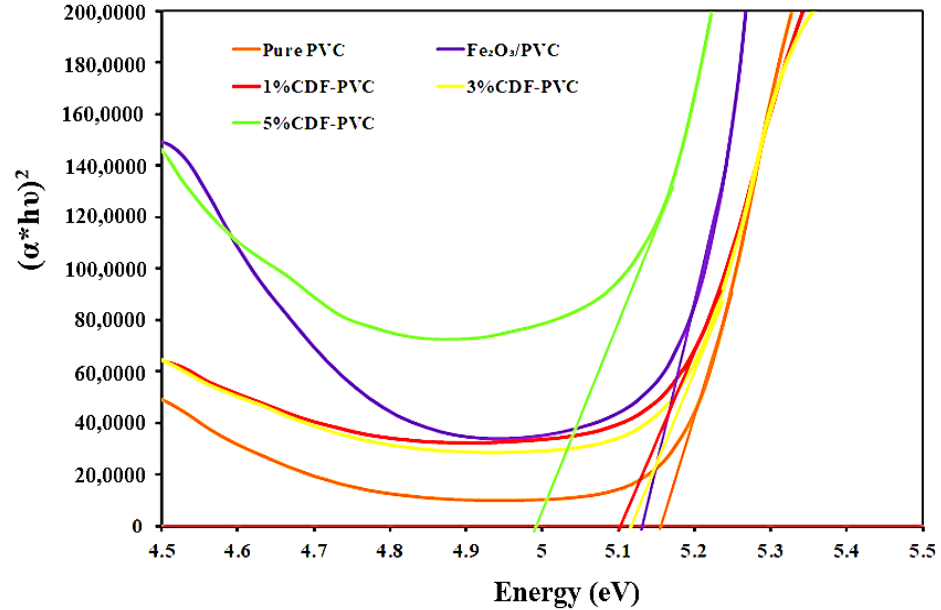
Figure 6. A comparison of the direct bandgap of PVC films and their composites.